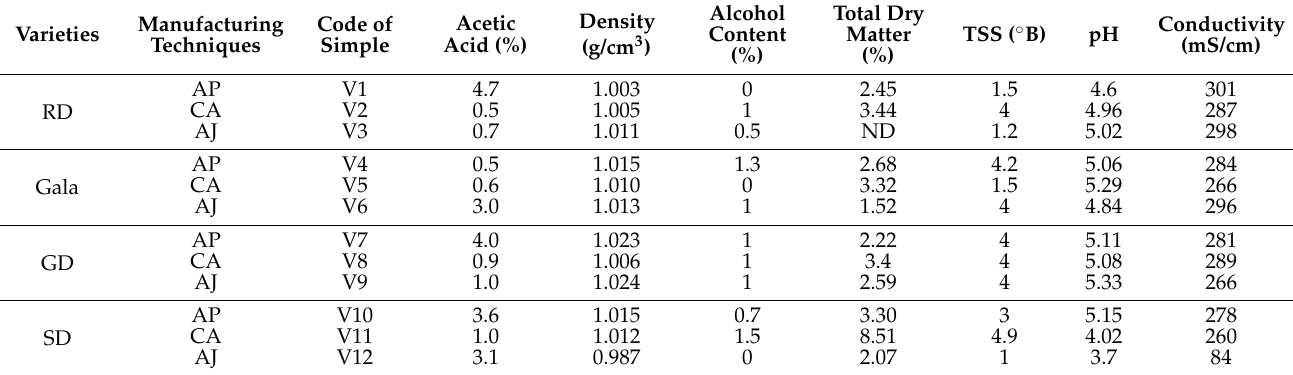
Table 1. Physicochemical characteristics of different samples of vinegar prepared by different methods and apple varieties. Manufacturing Varieties